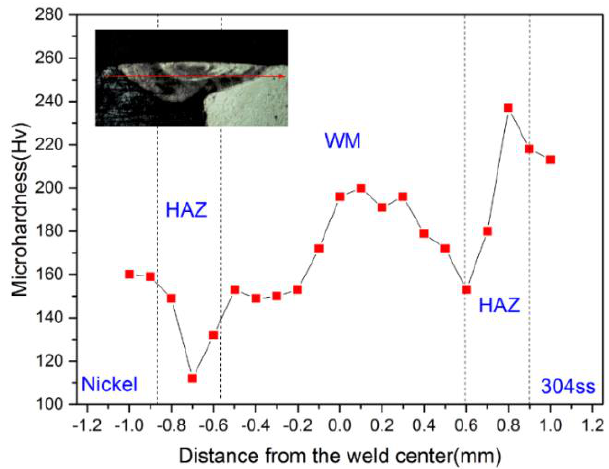
Figure 15. Spatial hardness distribution for laser welded joint of 304ss and Ni at the heat input of 40 J/mm.